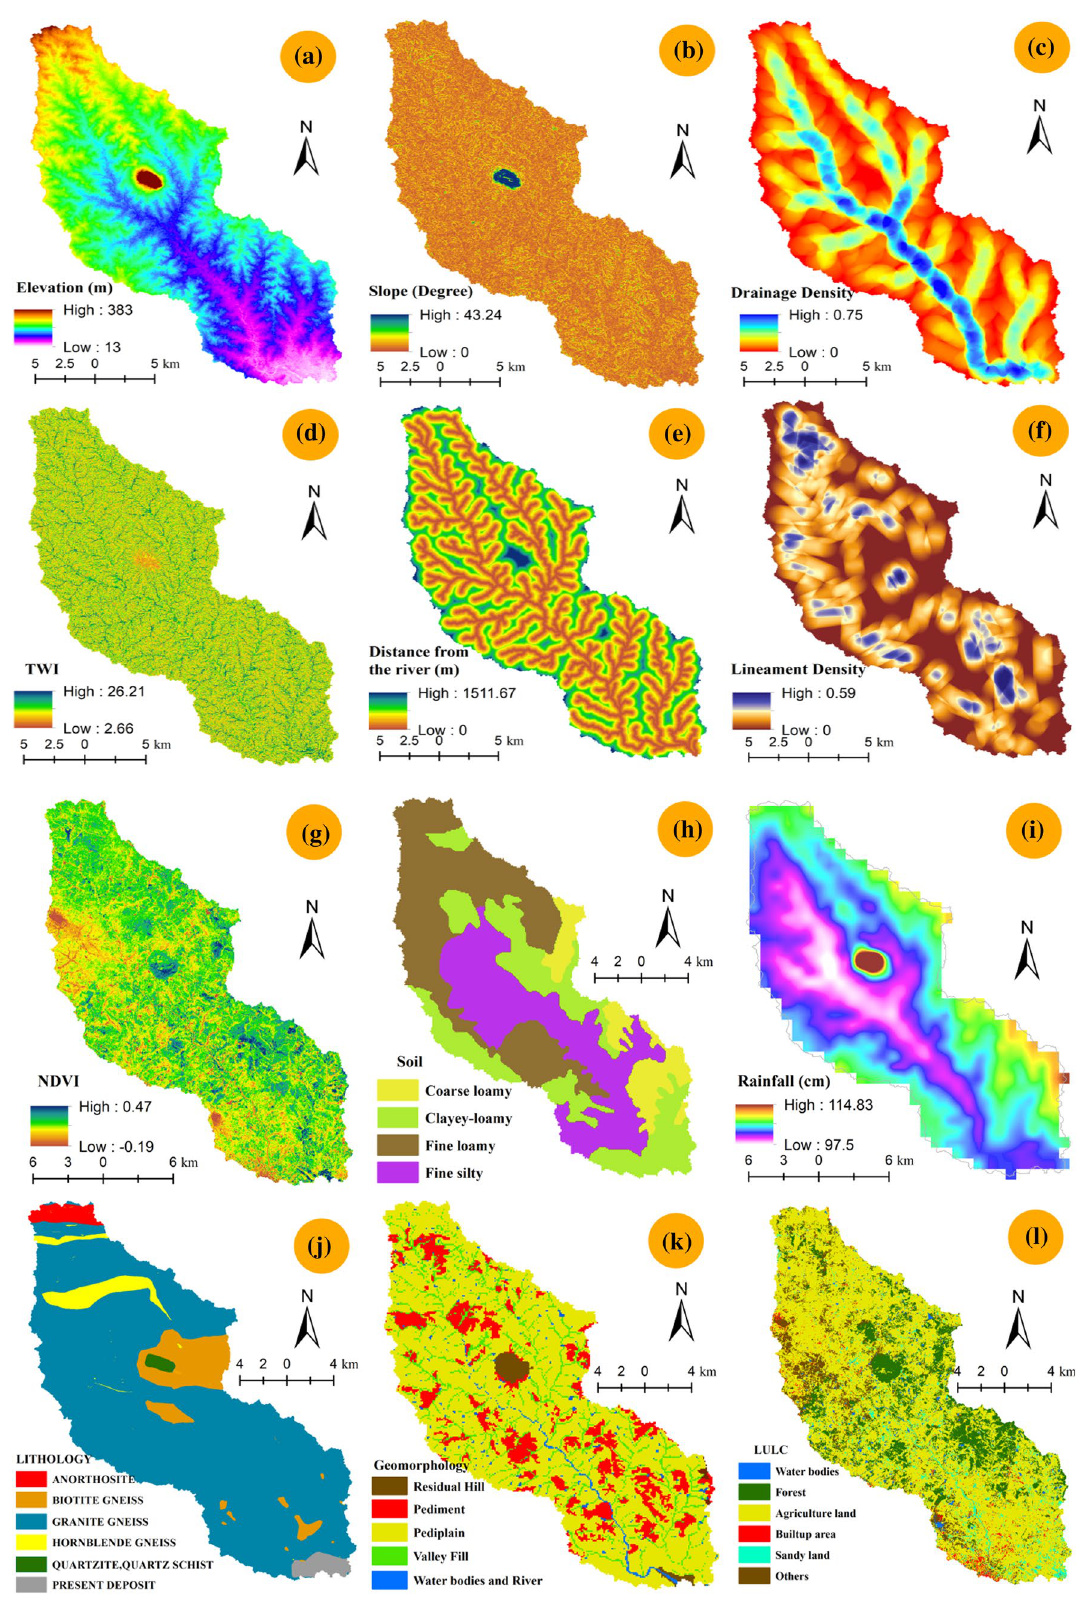
Fig. 3 Distribution of six causative factors used in this study: a elevation, b slope, c drainage density, d TWI, e distance from the river, f linea- ment, g NDVI, h soil, i rainfall, j lithology, k geomorphology and l